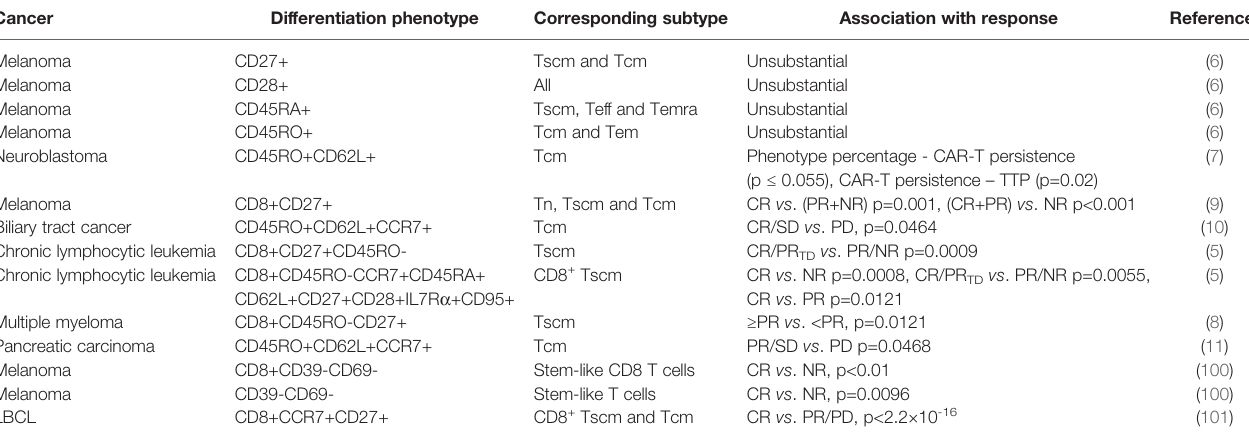
TABLE 3 | Association of differentiation phenotypes with response in clinical